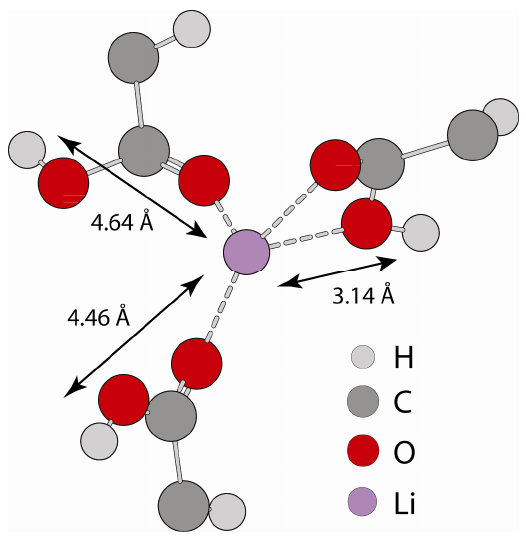
Figure 7. Extracted MD snap shot showing an example of the different 1 H- 7 Li bonding environments, and the corresponding 1 H- 7 Li